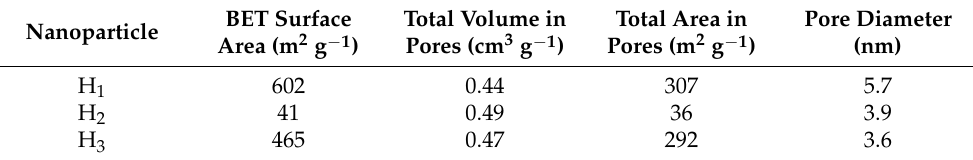
Table 3. BET surface area, total volume in pores, total area in pores, and pore diameter for all fabricated silica